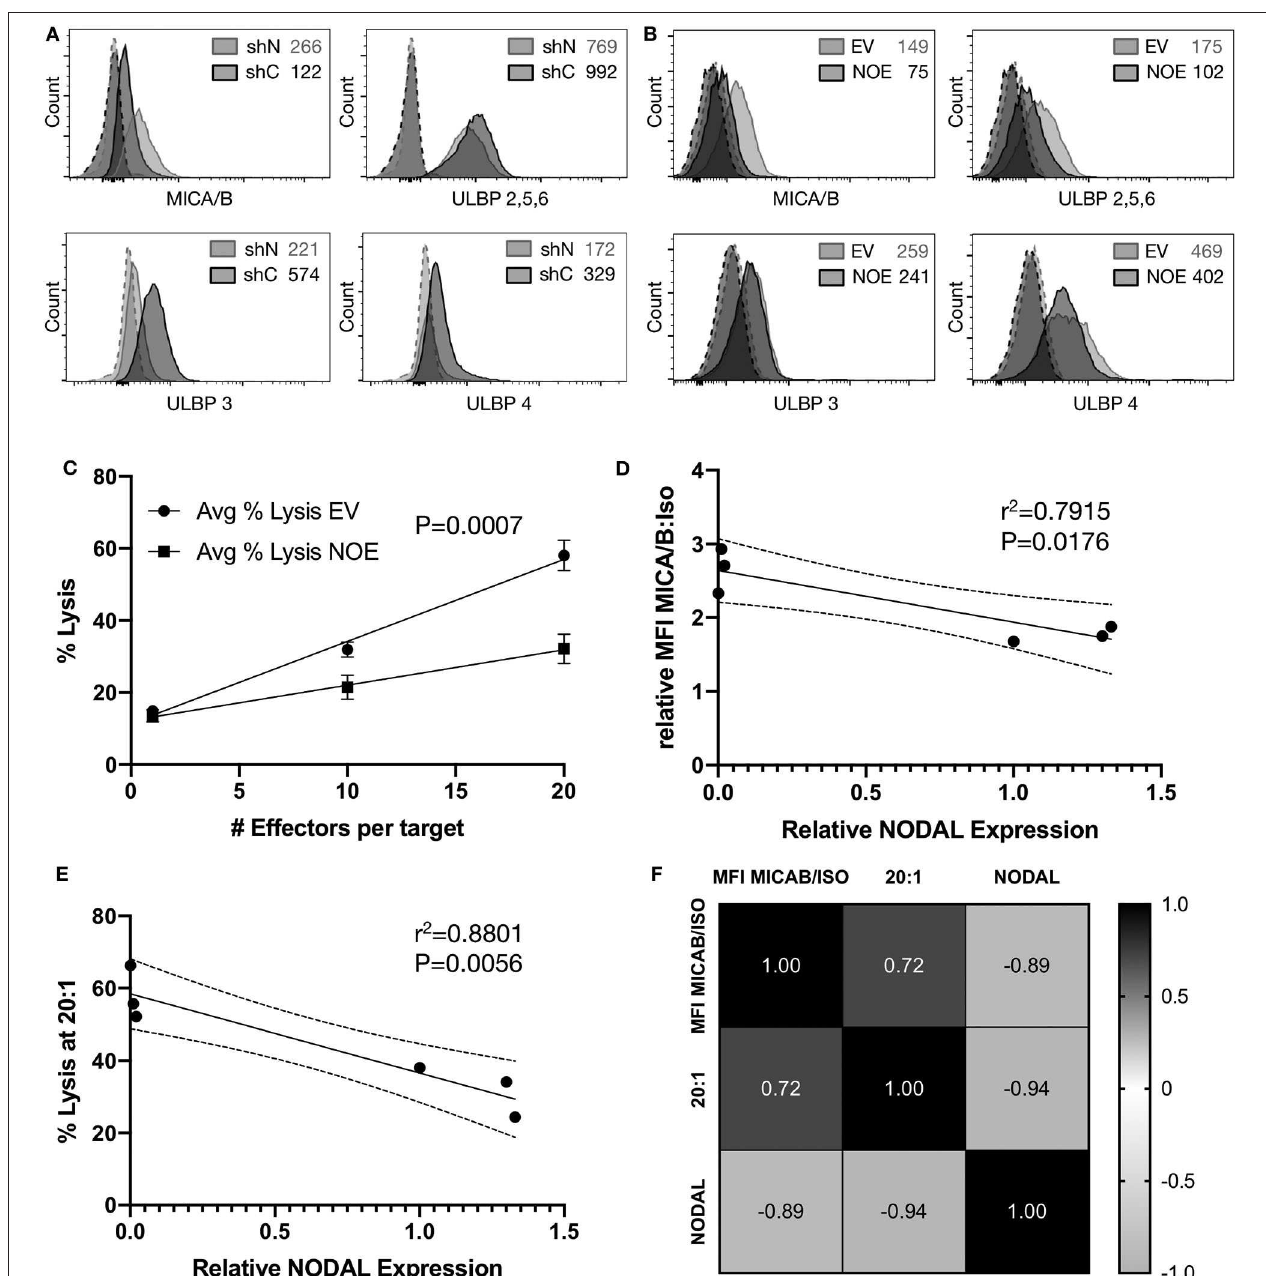
FIGURE 5 | Surface expression of MICA/B is inversely correlated to NODAL expression. (A) , Representative examples of MICA/B, ULBP2/5/6, ULBP3, and ULBP4 tumor antigen surface expression on shC and shN MDA-MB-231 cells. Dashed lines are isotope controls. Median fluorescence intensity (MFI) values are indicated. (B) , Representative examples of MICA/B, ULBP2/5/6, ULBP3, and ULBP4 tumor surface antigen expression on T47D EV and NOE cells. Dashed lines are isotope controls. Median fluorescence intensity (MFI) values are indicated. (C) , Linear regression analysis on data from cytotoxicity assays shown in 4D, S4K,L. Avg = average. (D) , Relative ratios of MFI for MICA/B stained cells over isotype controls were plotted against relative NODAL expression as determined by densitometry on protein expression in lysates from matched cells shown in Figure S4O . (E) , Average percent lysis at 20:1 effector:target ratio from experiments shown in 4D, S4K,L were plotted against relative NODAL expression as determined by densitometry shown in Figure S4O . (F) , Correlation matrix showing Pearson’s correlation coefficients from multiple variables analysis of percent lysis at 20:1, relative NODAL and MICA/B expression from experiments shown in Figure 4D , Figures S4K,L .